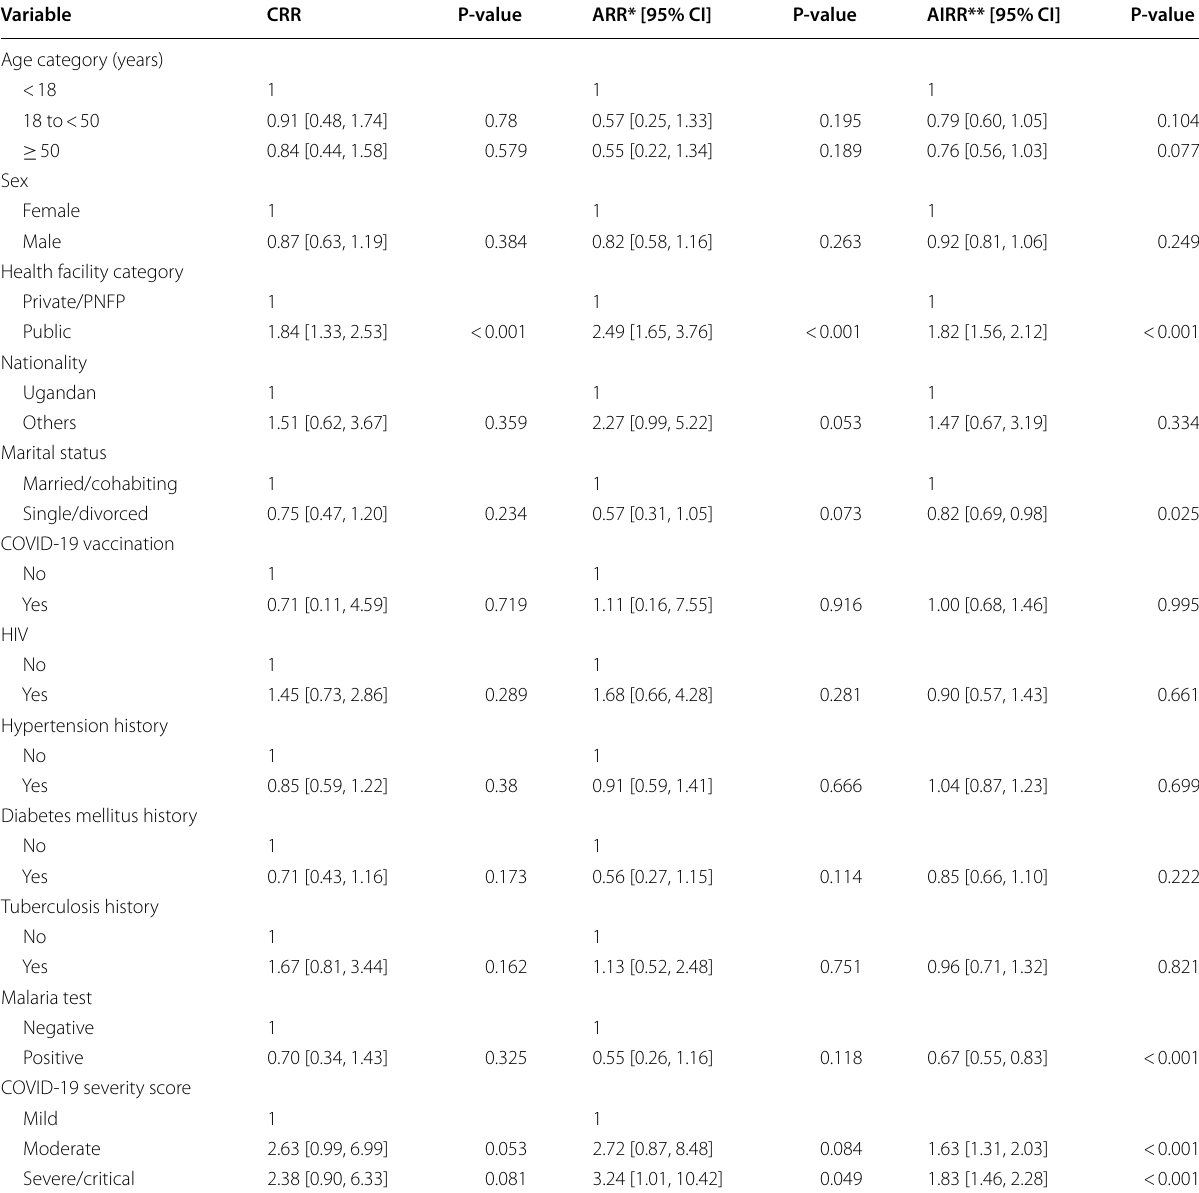
Table 2 Factors associated with prolonged hospitalization among patients with COVID-19 in Uganda